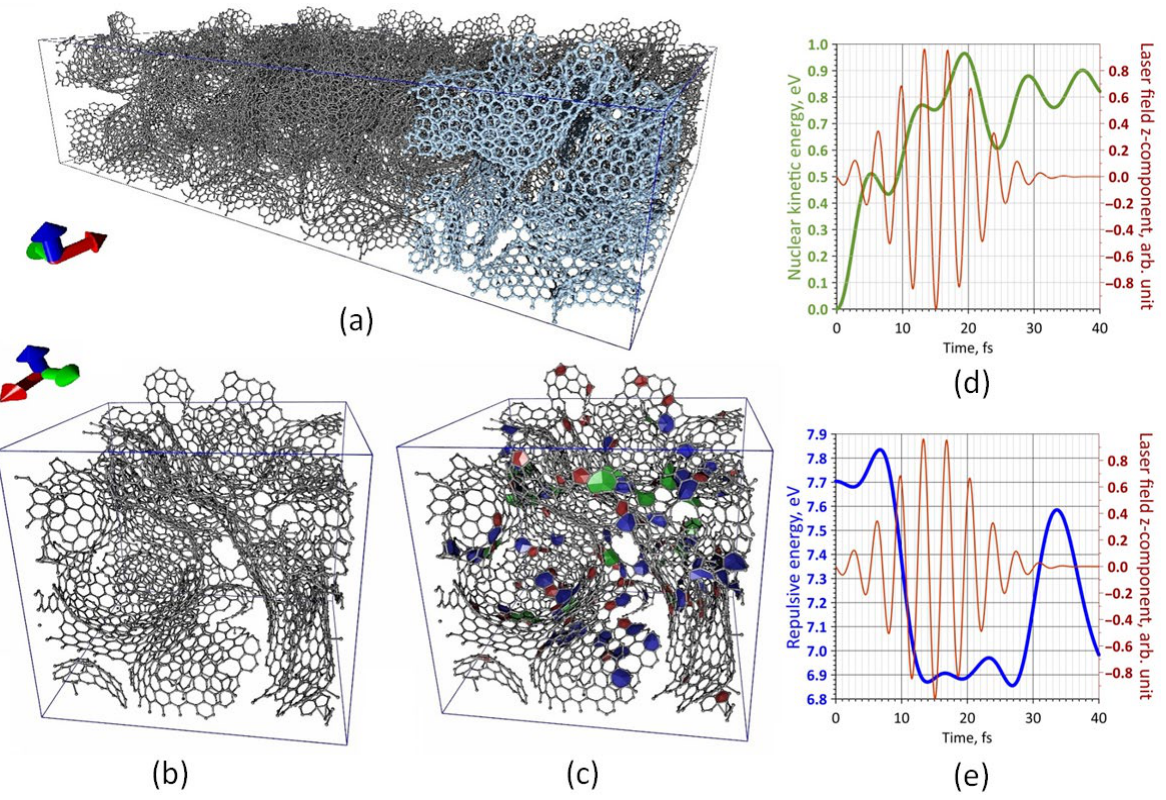
Figure 3. Atomic structure of a supercell of graphene nanoflakes layer: ( a ) General view of a layer fragment, ( b , c ) Two types of supercells; energy characteristics of the carbon atom detachment process under the action of the laser pulse: ( d ) Kinetic energy of the nuclei, ( e ) Repulsive energy. The constructed atomistic supercell model included 24 octagons, 75 pentagons,